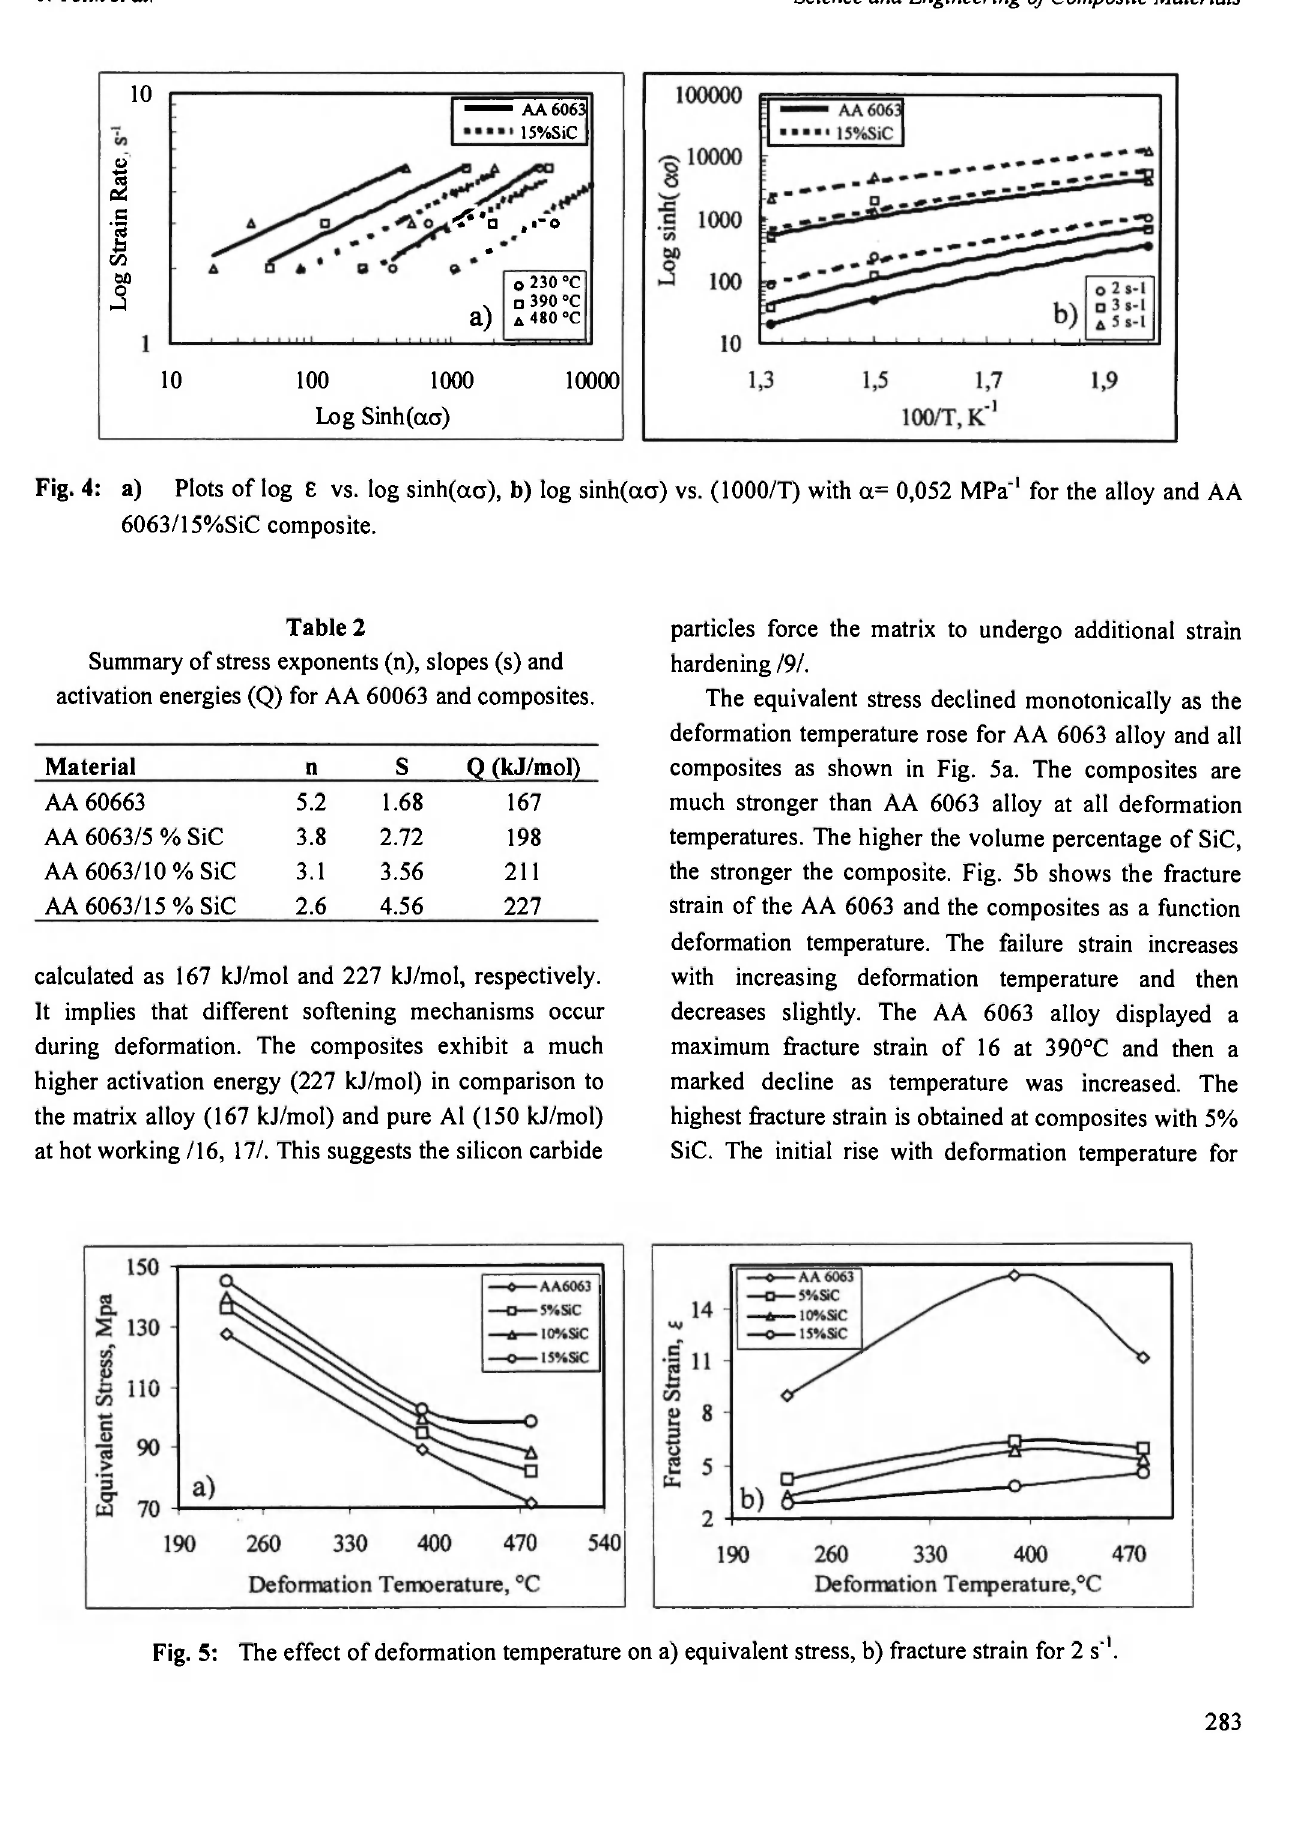
Fig. 5: The effect of deformation temperature on a) equivalent stress, b) fracture strain for 2